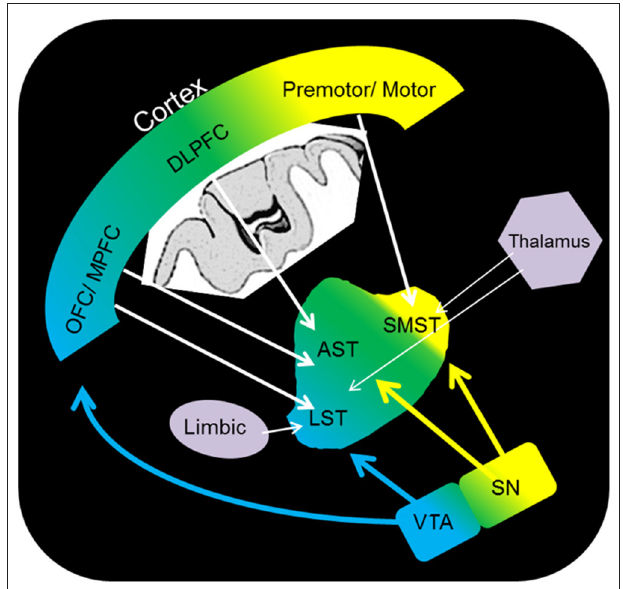
FIGURE 1 | Schematic representation of the dopamine pathway. OFC, orbitofrontal cortex; DLPFC, dorsolateral prefrontal cortex; premotor/motor, premotor/motor cortex; SMST, sensorimotor striatum; AST, associative striatum; LST, limbic striatum; VTA, ventral tegmental area; SN, substantia